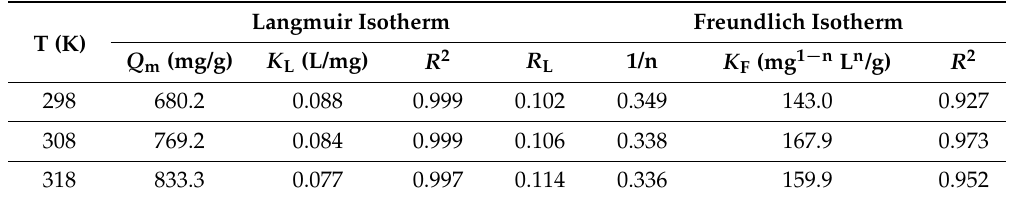
Table 4. Comparison of Hg 2+ removal capability.